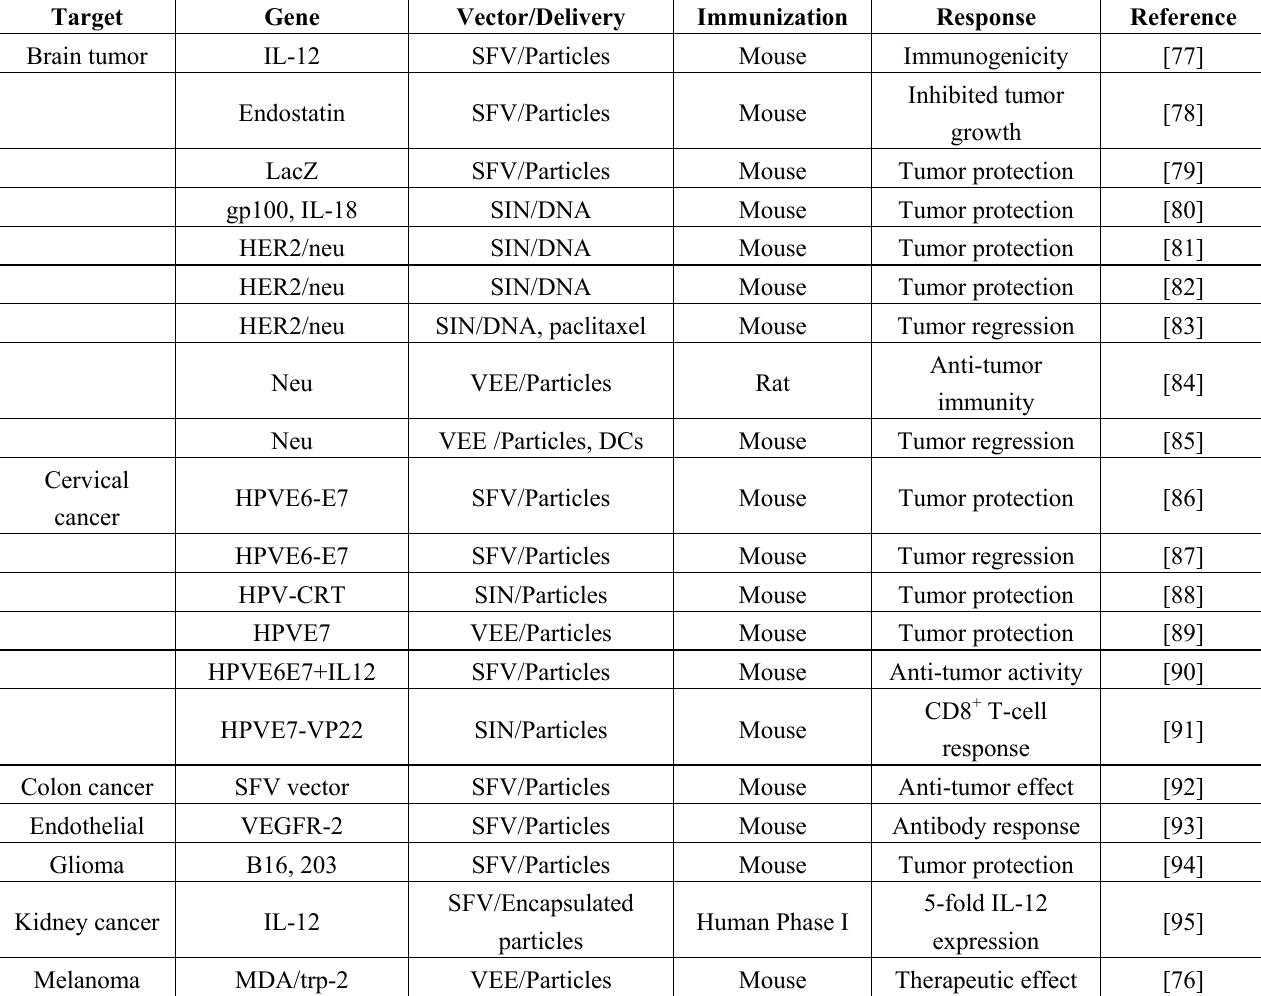
Table 3. Alphavirus-based vaccine development for cancer